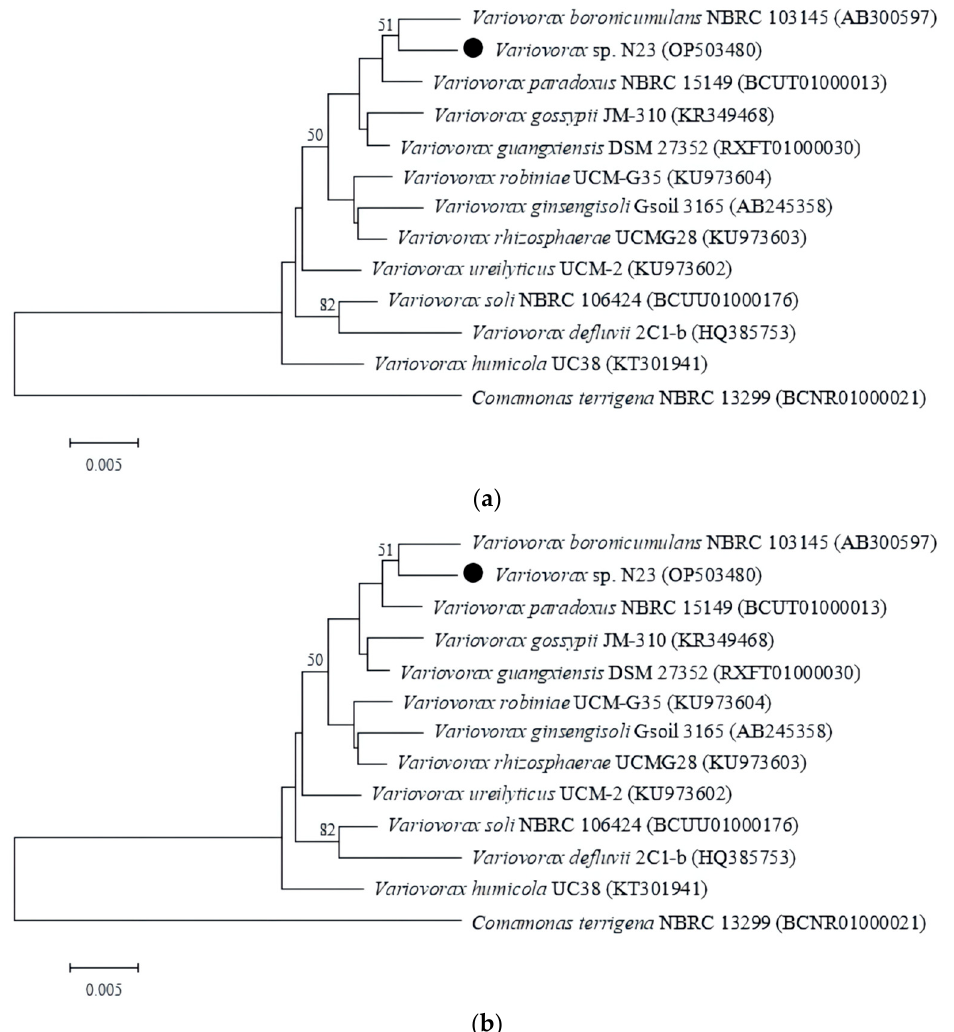
Figure 2. Phylogenetic relationship of strain N23 with its closely related strains. ( a ) A neighbor- joining tree illustrating the phylogenetic relationship of strain N23 and its closely related type strains of genus Variovorax constructed based on the 16S rRNA gene sequences. The numbers at branch points indicate bootstrap percentages based on 1,000 replicates. Only values > 50% are shown. The genus Comamonas , affiliated with the same family Comamonadaceae , was selected as the